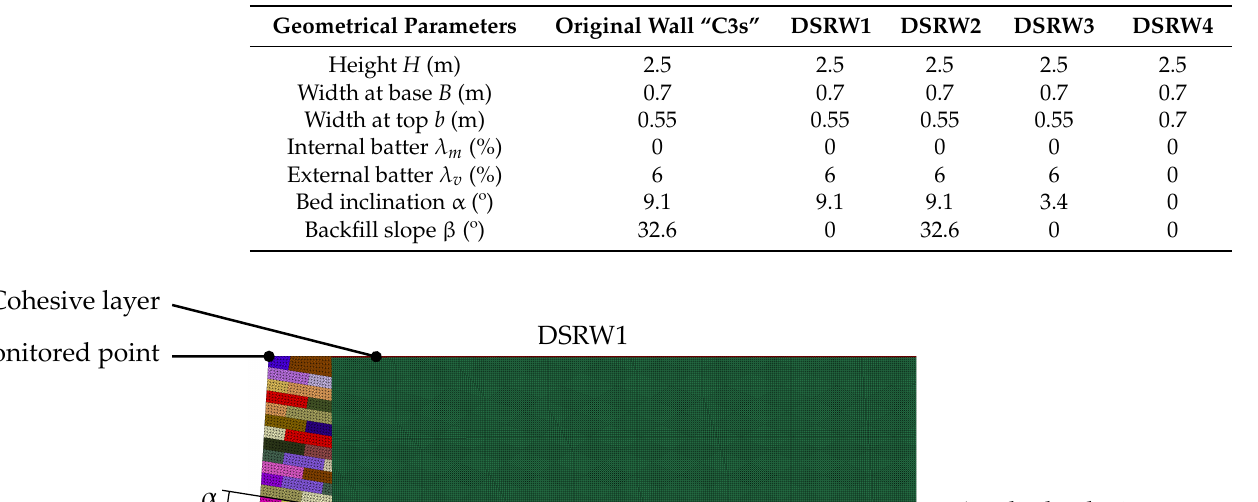
Table 5. Geometric parameters of the case study wall “C3s” and the DSRWs numerically simulated in Section 4 [16]. The reader is referred to Figure 9 to understand the geometries better.